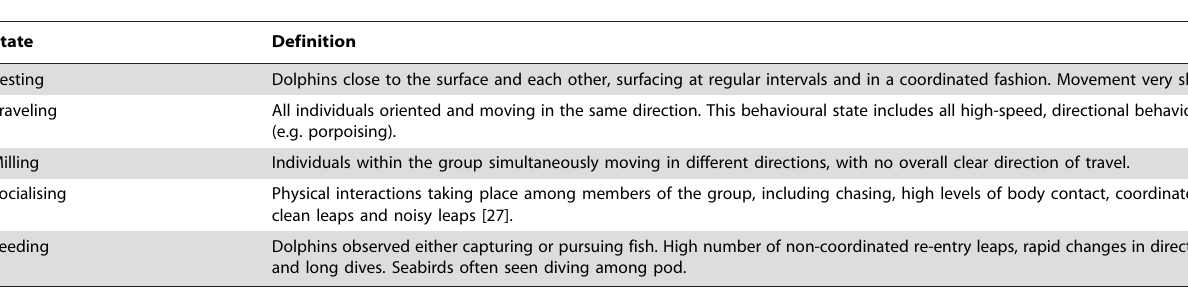
Table 1. Definitions of group behavioral states of dusky